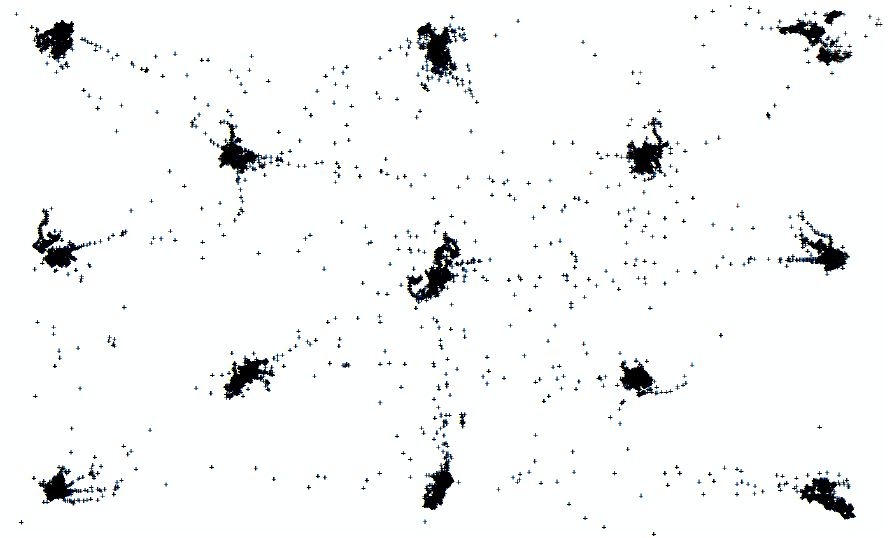
Figure 8. An overview of the registered raw data for the 13 target points.